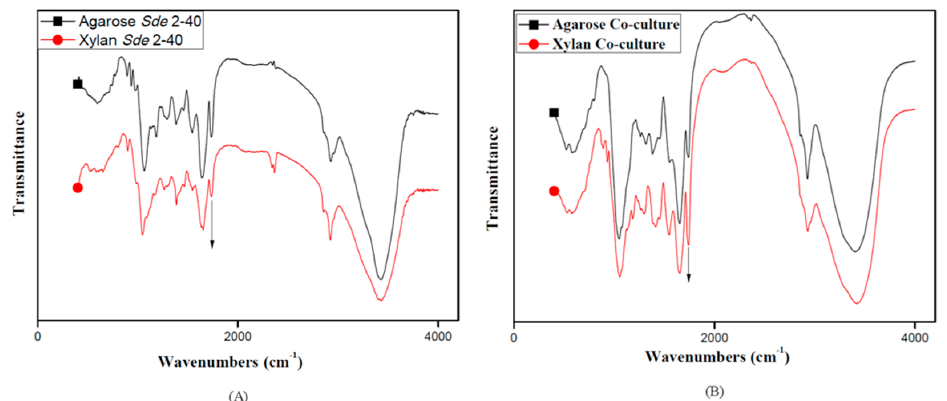
Figure 5. Fourier Transform-Infrared Spectroscopy (FT-IR) spectrum of PHA accumulating cells grown on different carbon sources. The characteristic PHA peaks are ester-carbonyl bond at 1727–1750 cm − 1 . ( A ) Sde 2-40 and ( B ) co-culture.